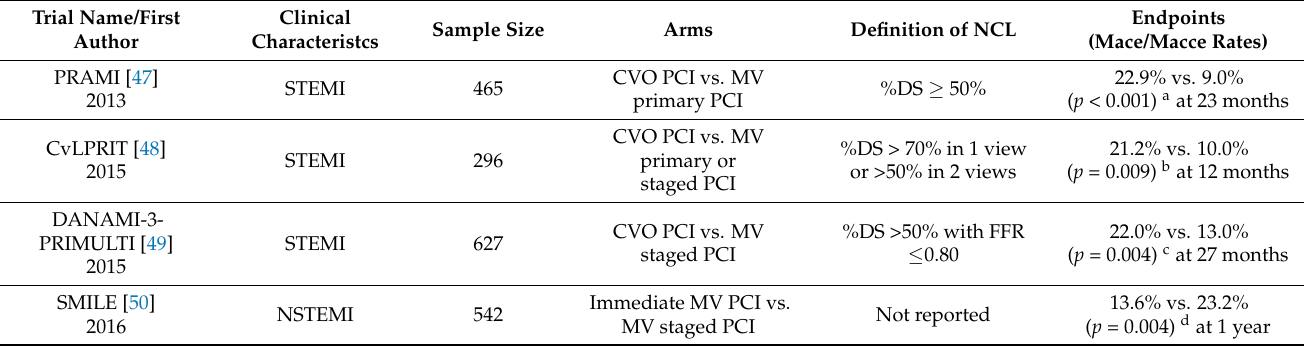
Table 2. Overview of the key randomized control trials comparing revascularization strategies in patients with acute myocardial infarction and multivessel